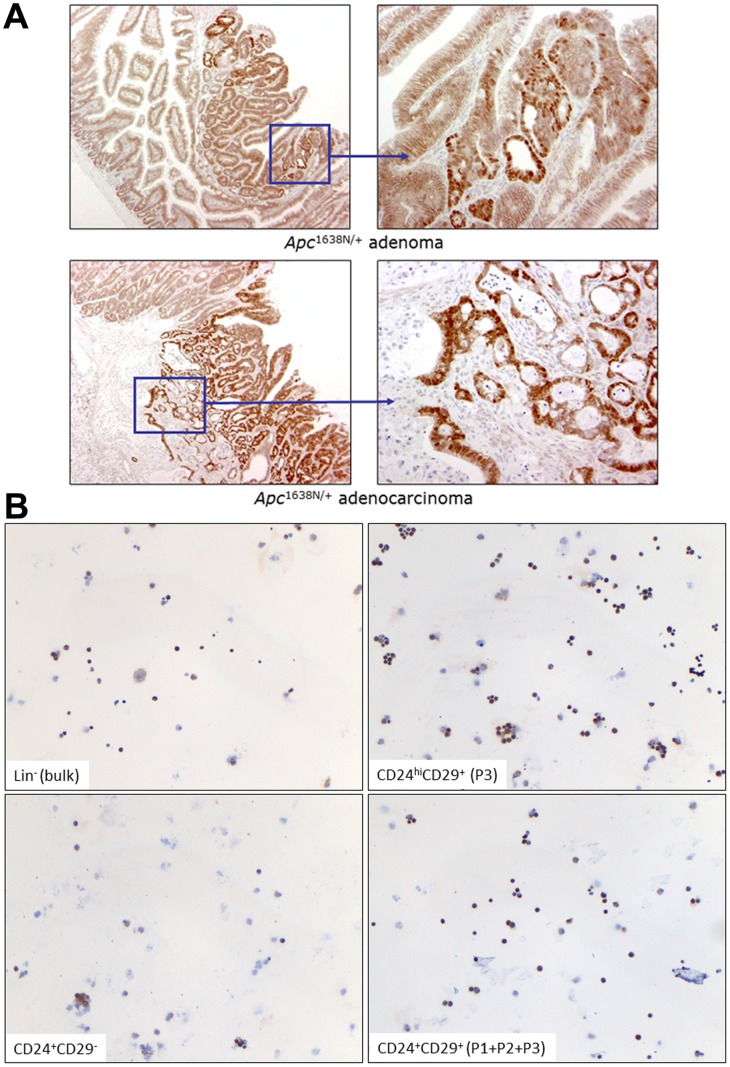
β-catenin expression analysis in Apc
1638N/+ and Apc
1638N/+/KRAS
V12G intestinal tumours.Immuno-histochemistry (a.,b.) and western blot (c.) analysis of β-catenin in primary Apc
1638N/+ intestinal adenomas (a.) and in FACSorted tumour populations from Apc
1638N/+/KRAS
V12G intestinal tumours (b. and c.). The bars in c. represents the quantification of the bands obtained with an anti-active β-catenin Ab (anti-ABC; clone 8E7, #05–665, Millipore) by scanning and analyzing the western blot with the Odyssey scanner and after normalization with β-actin.